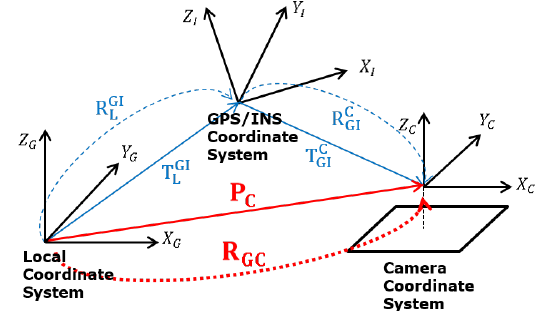
Figure 8. Coordinate systems and involved parameters in the system calibration